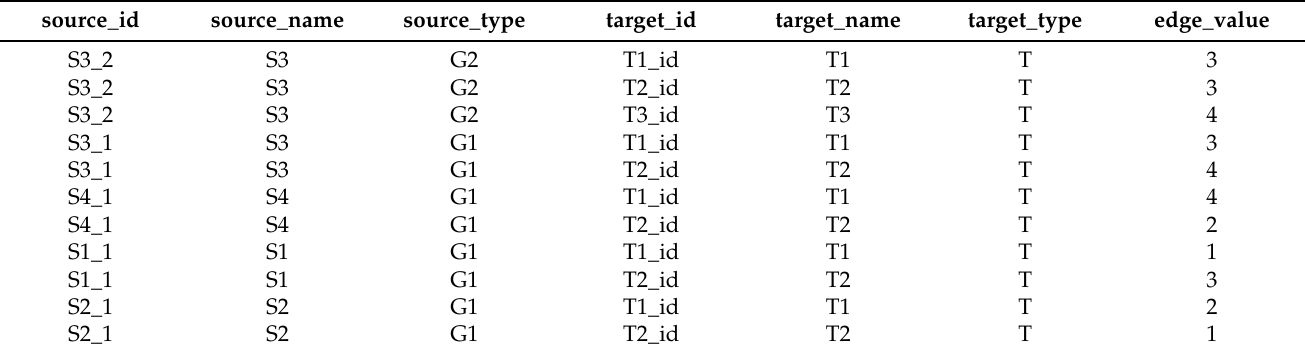
Table 3. The full input data format, populated with data from the third example described in Section 2.1.3. These data are visualized in Figure